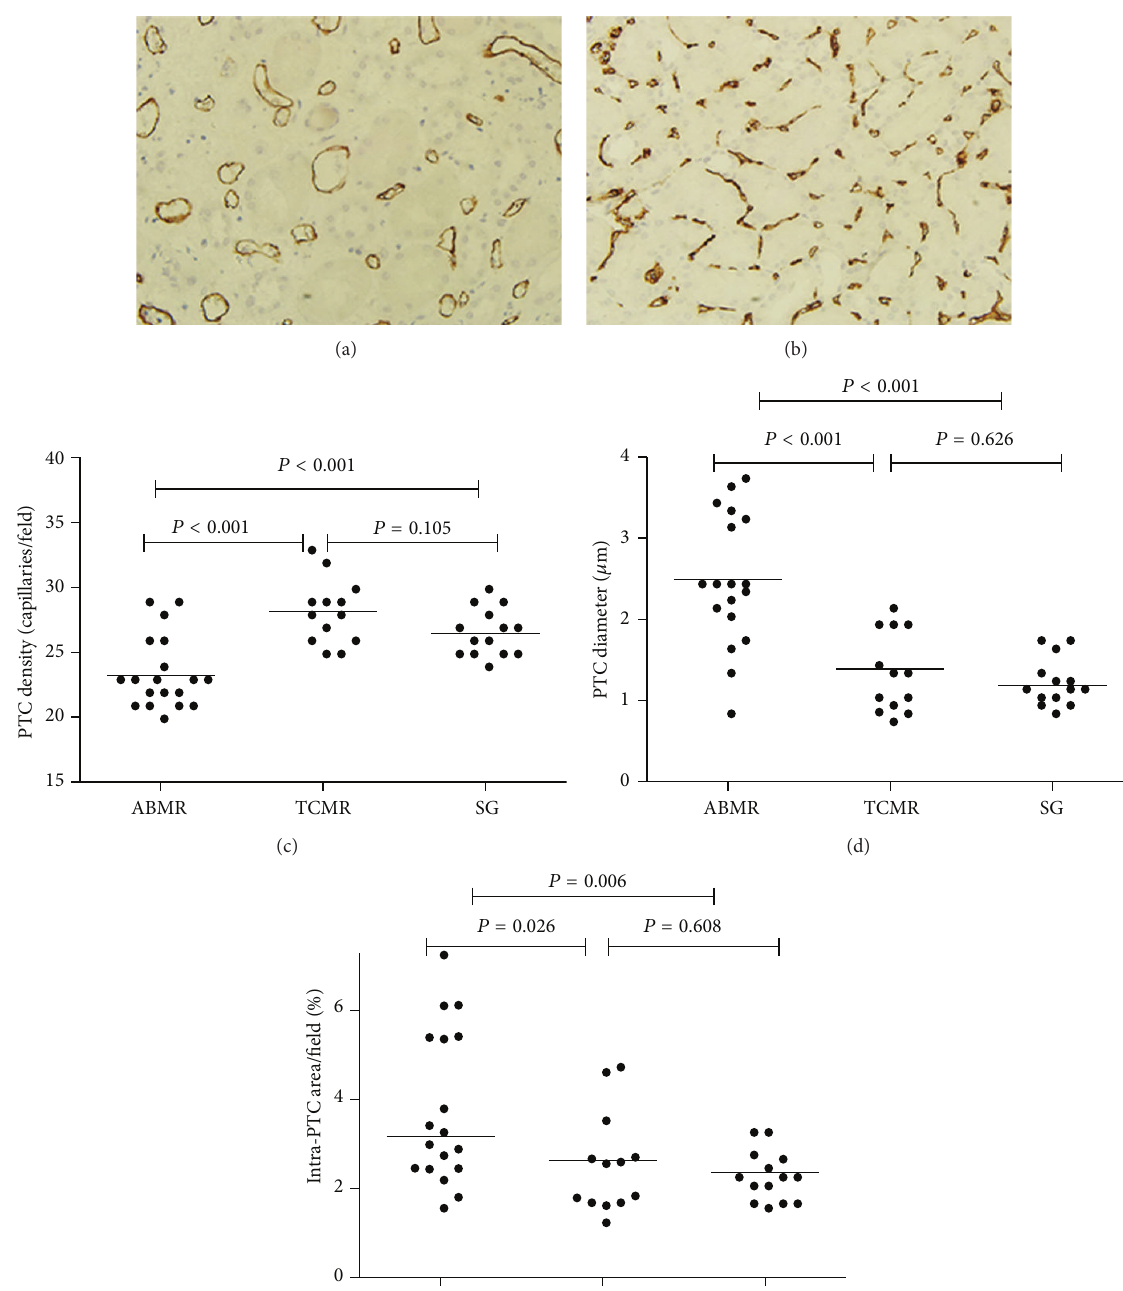
Figure 1: Peritubular capillary (PTC) dilation and rarefaction in antibody-mediated rejection (ABMR). Labeling the endothelial cells for CD31 showed PTC dilation and rarefaction in ABMR group (a), compared with PTC staining in T cell-mediated rejection (TCMR) group (b). (c) PTC density among the three groups revealed a rarefaction of PTCs in ABMR group. (d) PTC diameters among the three groups revealed significant PTC dilation in ABMR group. (e) Intra-PTC areas among the three groups revealed significant PTC enlargement in ABMR group. (a, b) Original magnification, ×